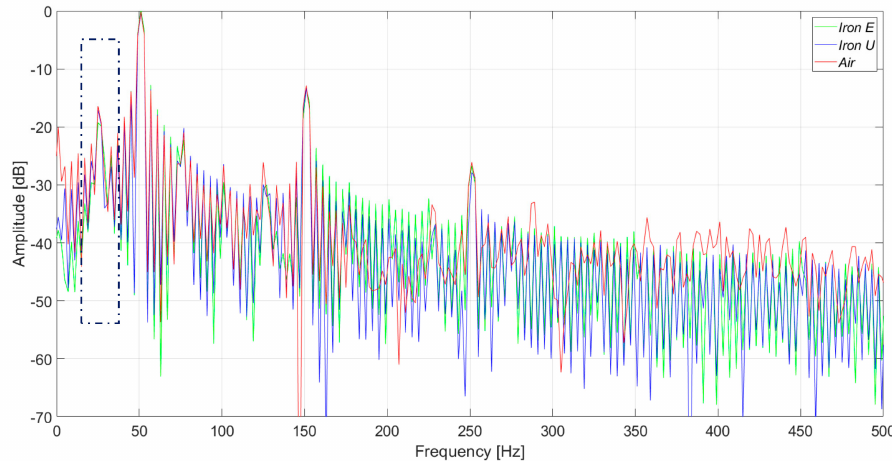
Figure 12. Frequency analysis of the induced voltage measurement with a 5% inter-turn rotor fault severity, in the upside